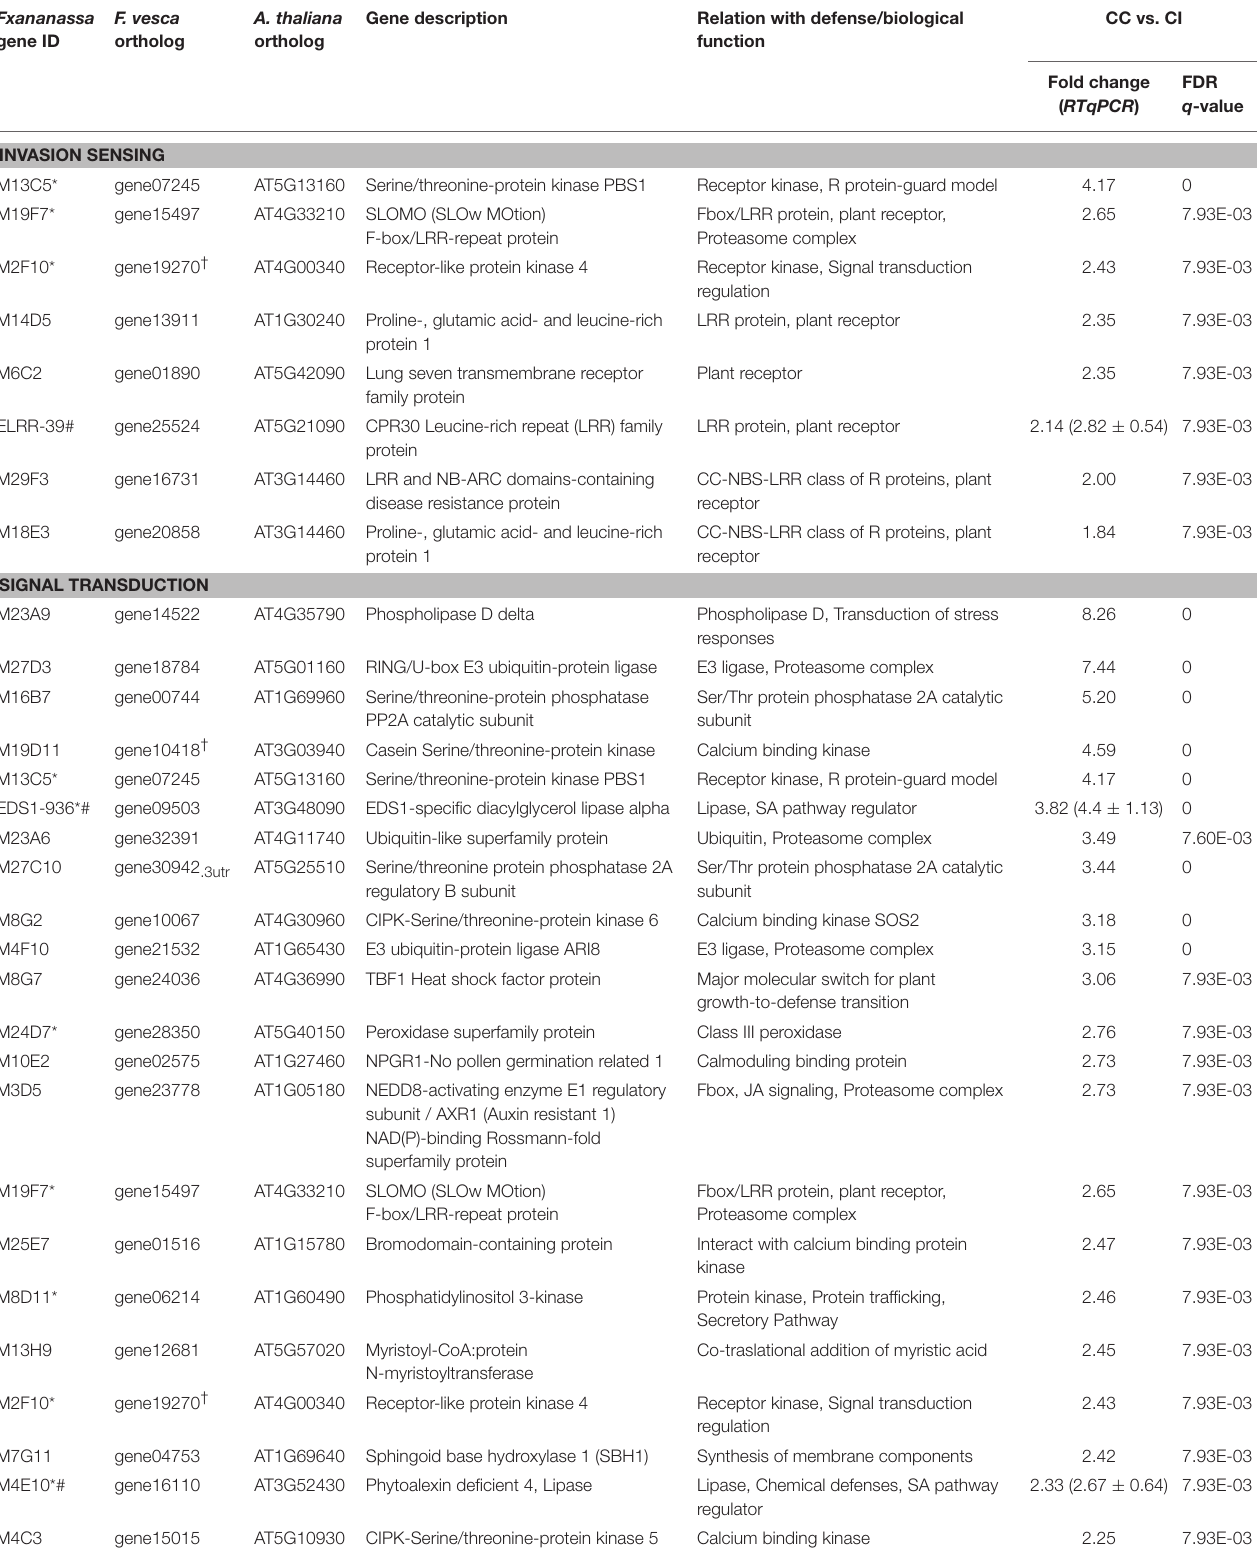
TABLE 1A | Up-regulated genes by Colletotrichum acutatum in crown tissue of Fragaria x ananassa , cultivar